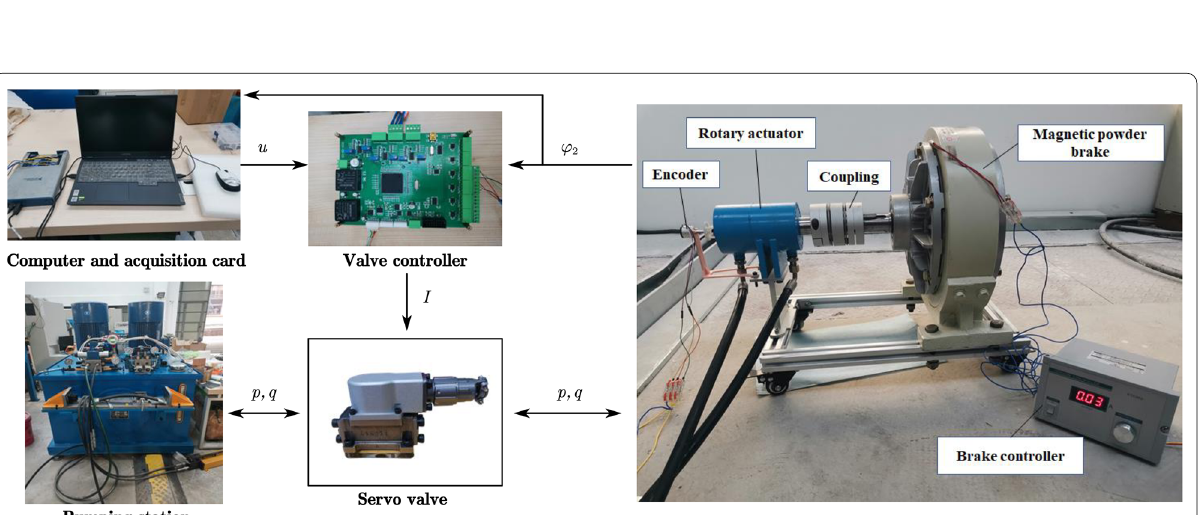
Figure 9 Test platform and schematic diagram of valve-controlled HHRA